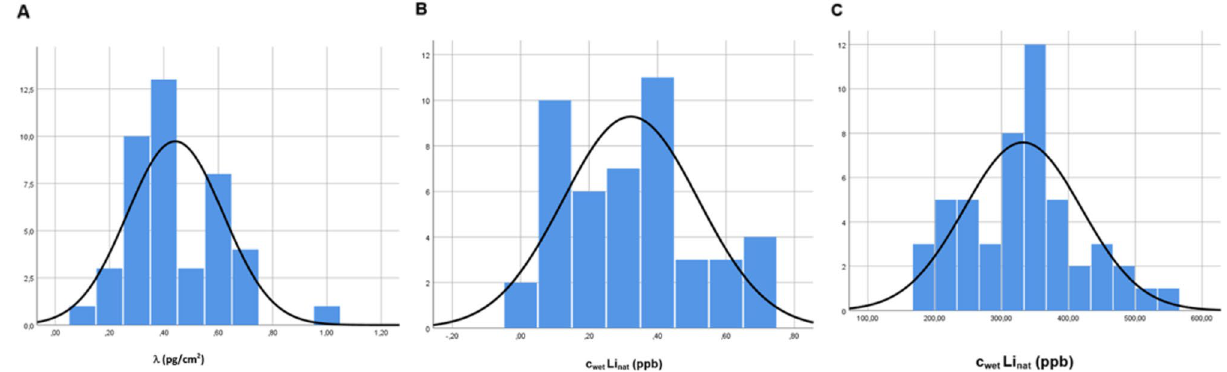
Figure 2. Histogram of lithium distribution in the brain* ( A ) case I; ( B ) case II; ( C ) case III. *Case A: lithium area density λ; Case II, III: spatially resolved lithium concentration c wet Li nat